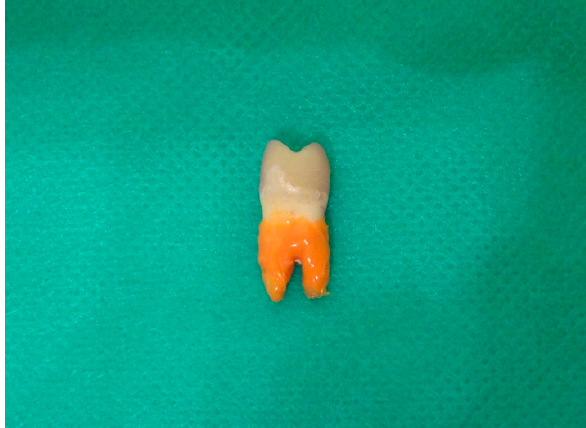
Figure 1. Premolar tooth with removed palatal tubercle.